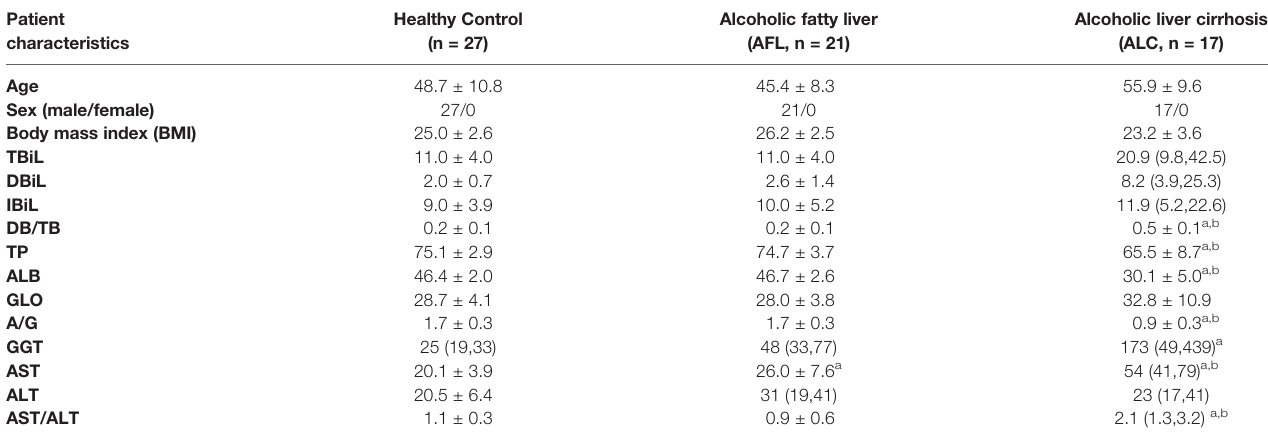
TABLE 1 | Patient